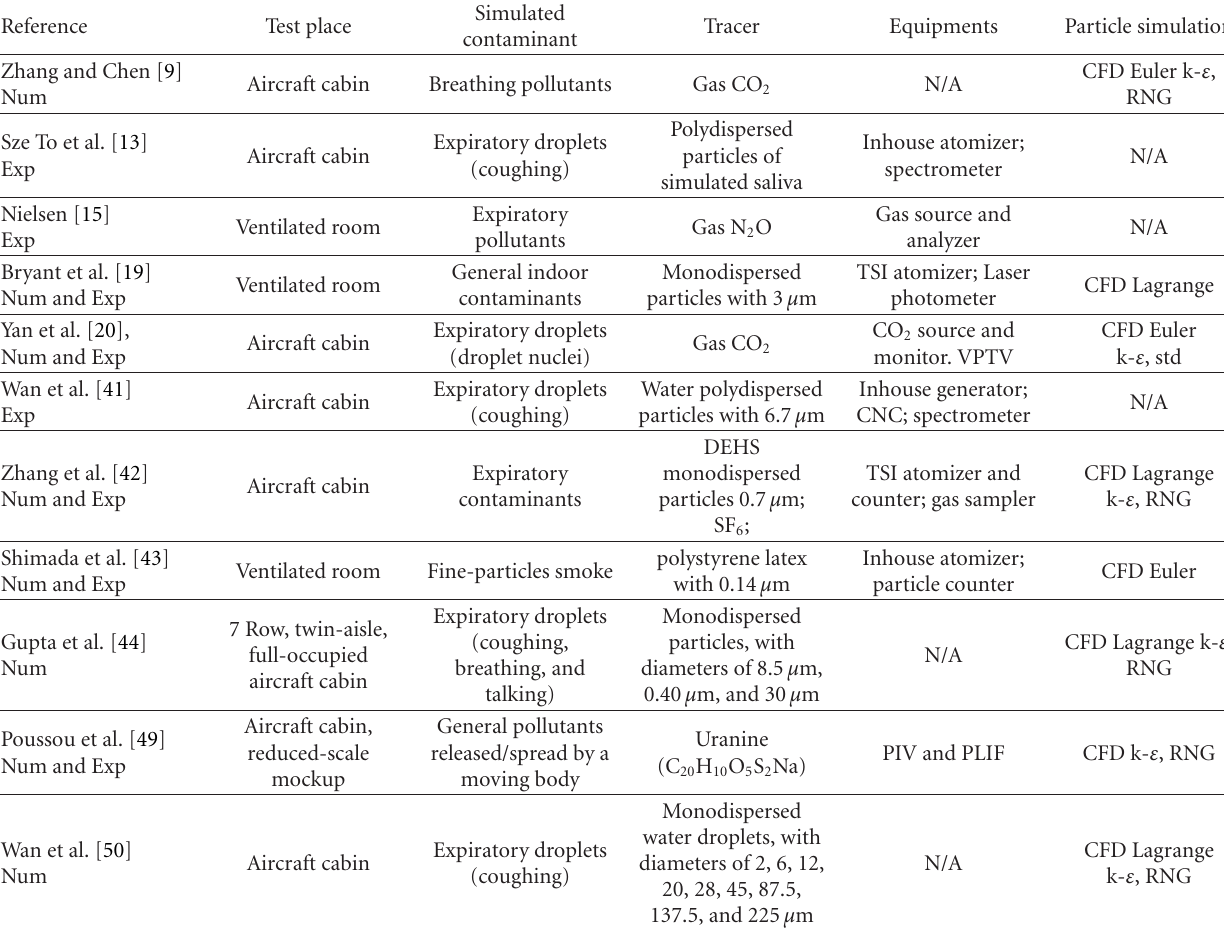
Table 3: Studies related to airborne dispersion of contaminants and some methods’ aspects.